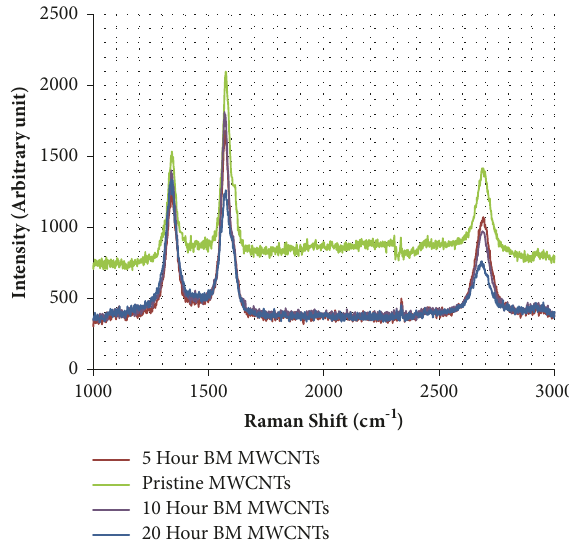
Figure 3: Raman spectroscopy of pristine and ball-milled MWCNTs.